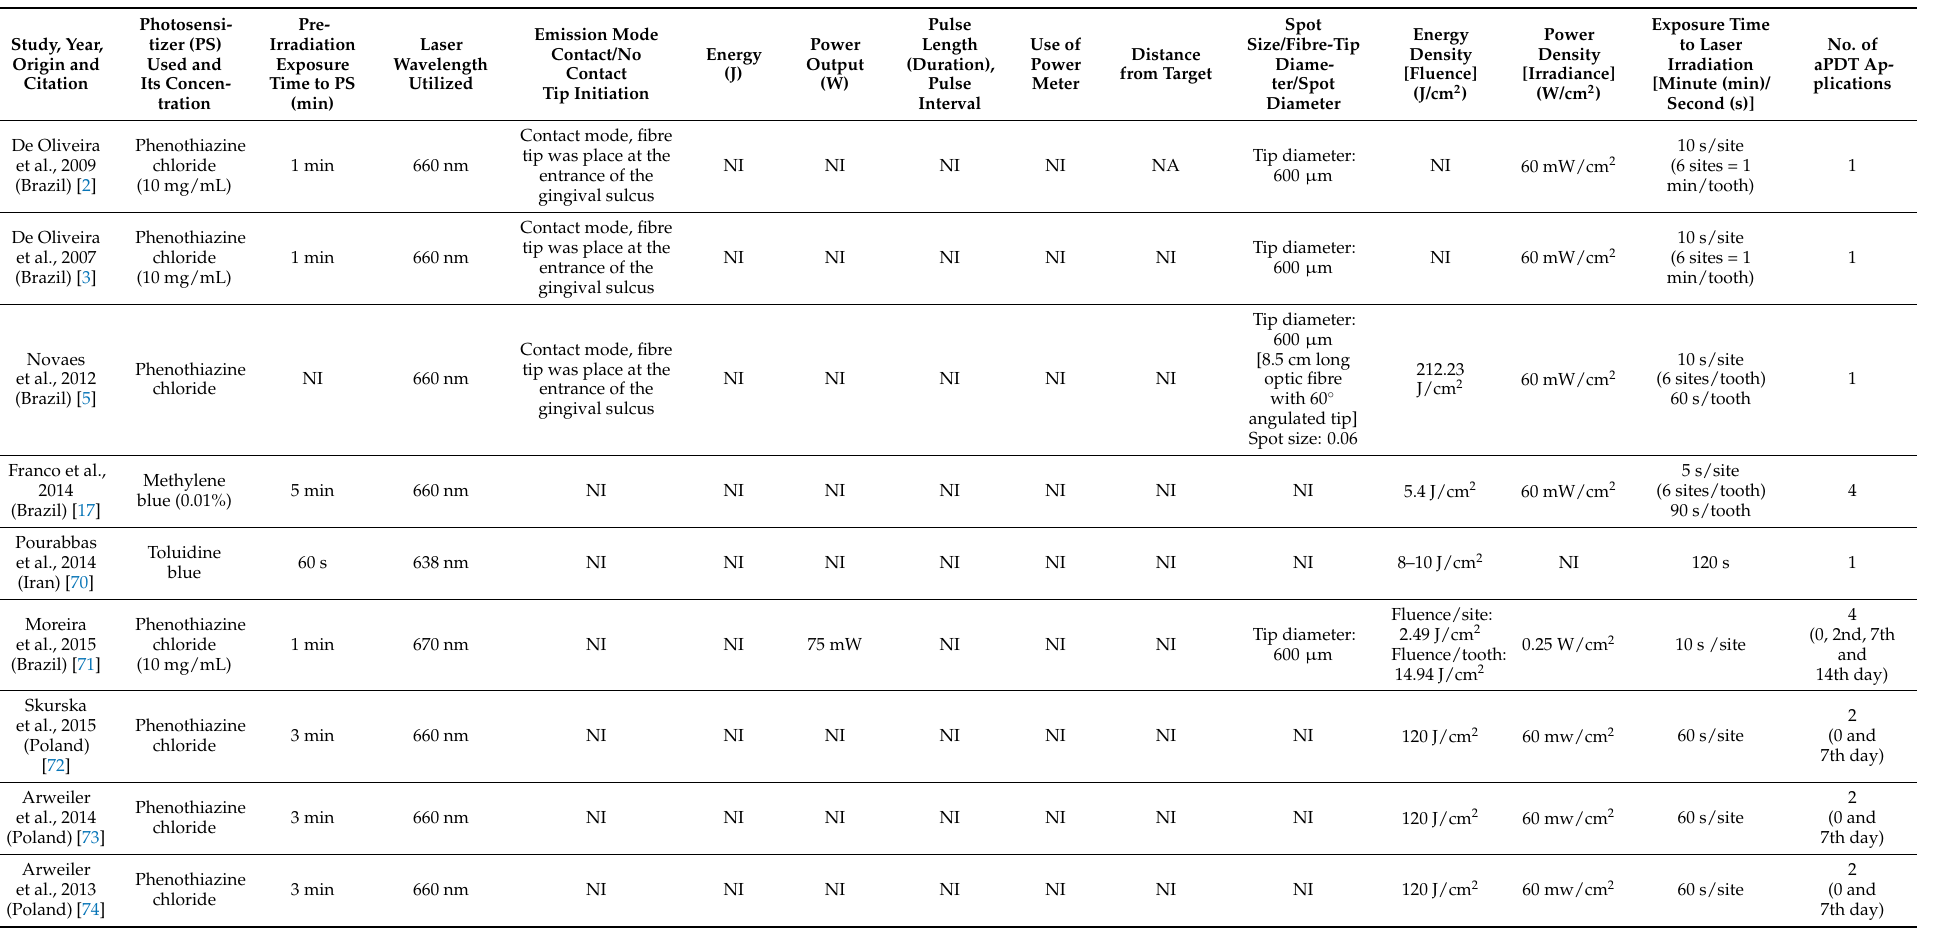
Table 2. Tabular representation of PS dye and laser parameters utilized for aPDT in the selected eligible in vivo human studies. Refer to Supplementary file 2 for list of